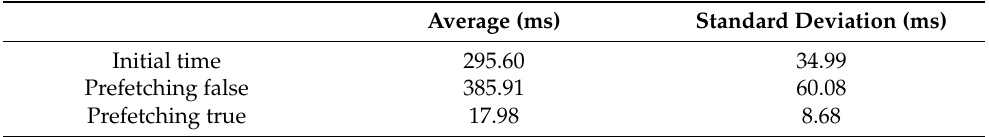
Table 4. Mean and standard deviation of the AR content loading of the proposed method.